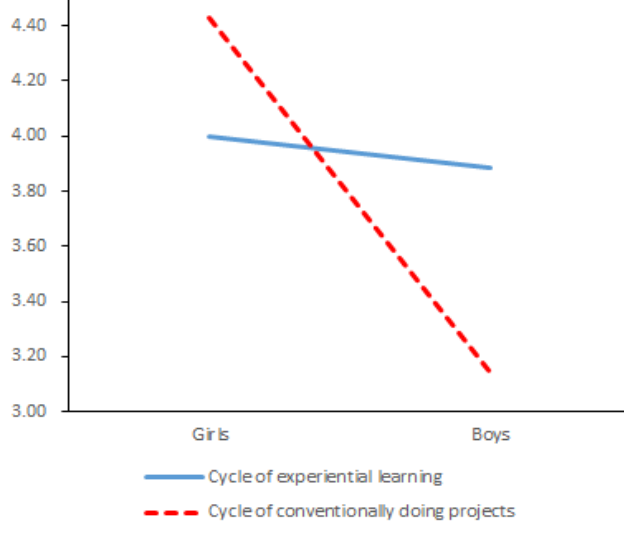
Interaction Between Learning Approach and Gender Regarding Students’ VUI